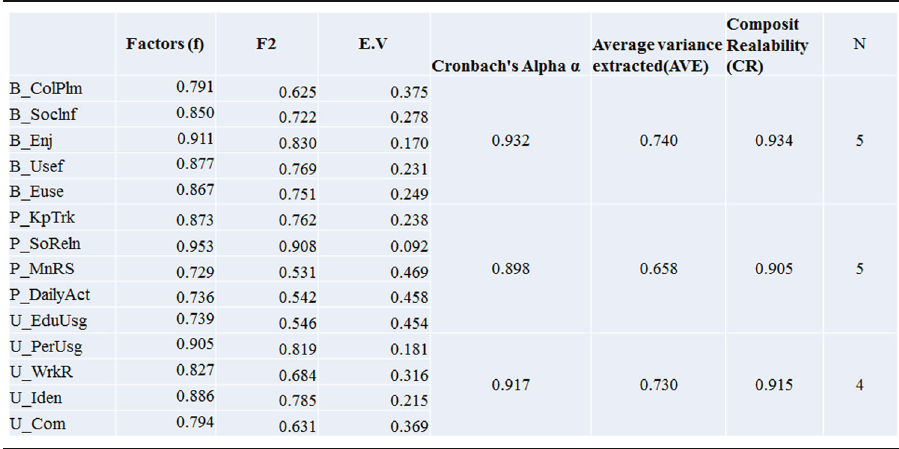
Table 5 average variance extracted (AVE) and composite reliability (CR)